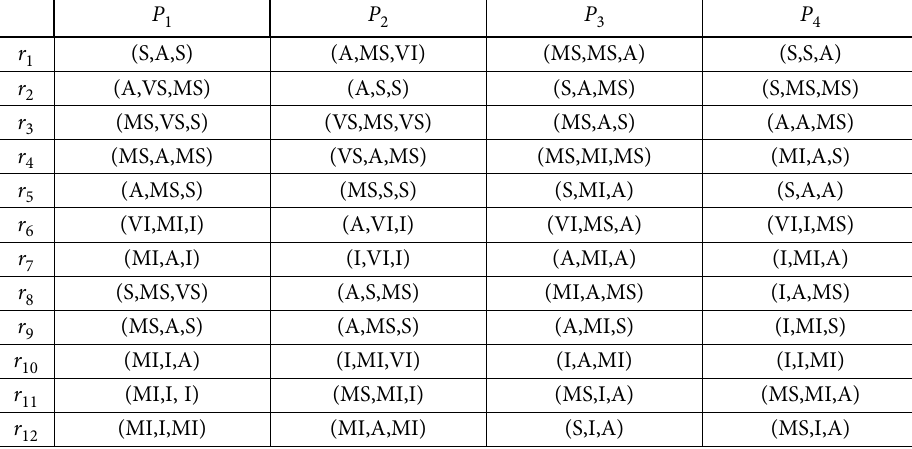
Table 3. LVs of alternative under different evaluate the IoT risks by DEs P 1 P 2 P